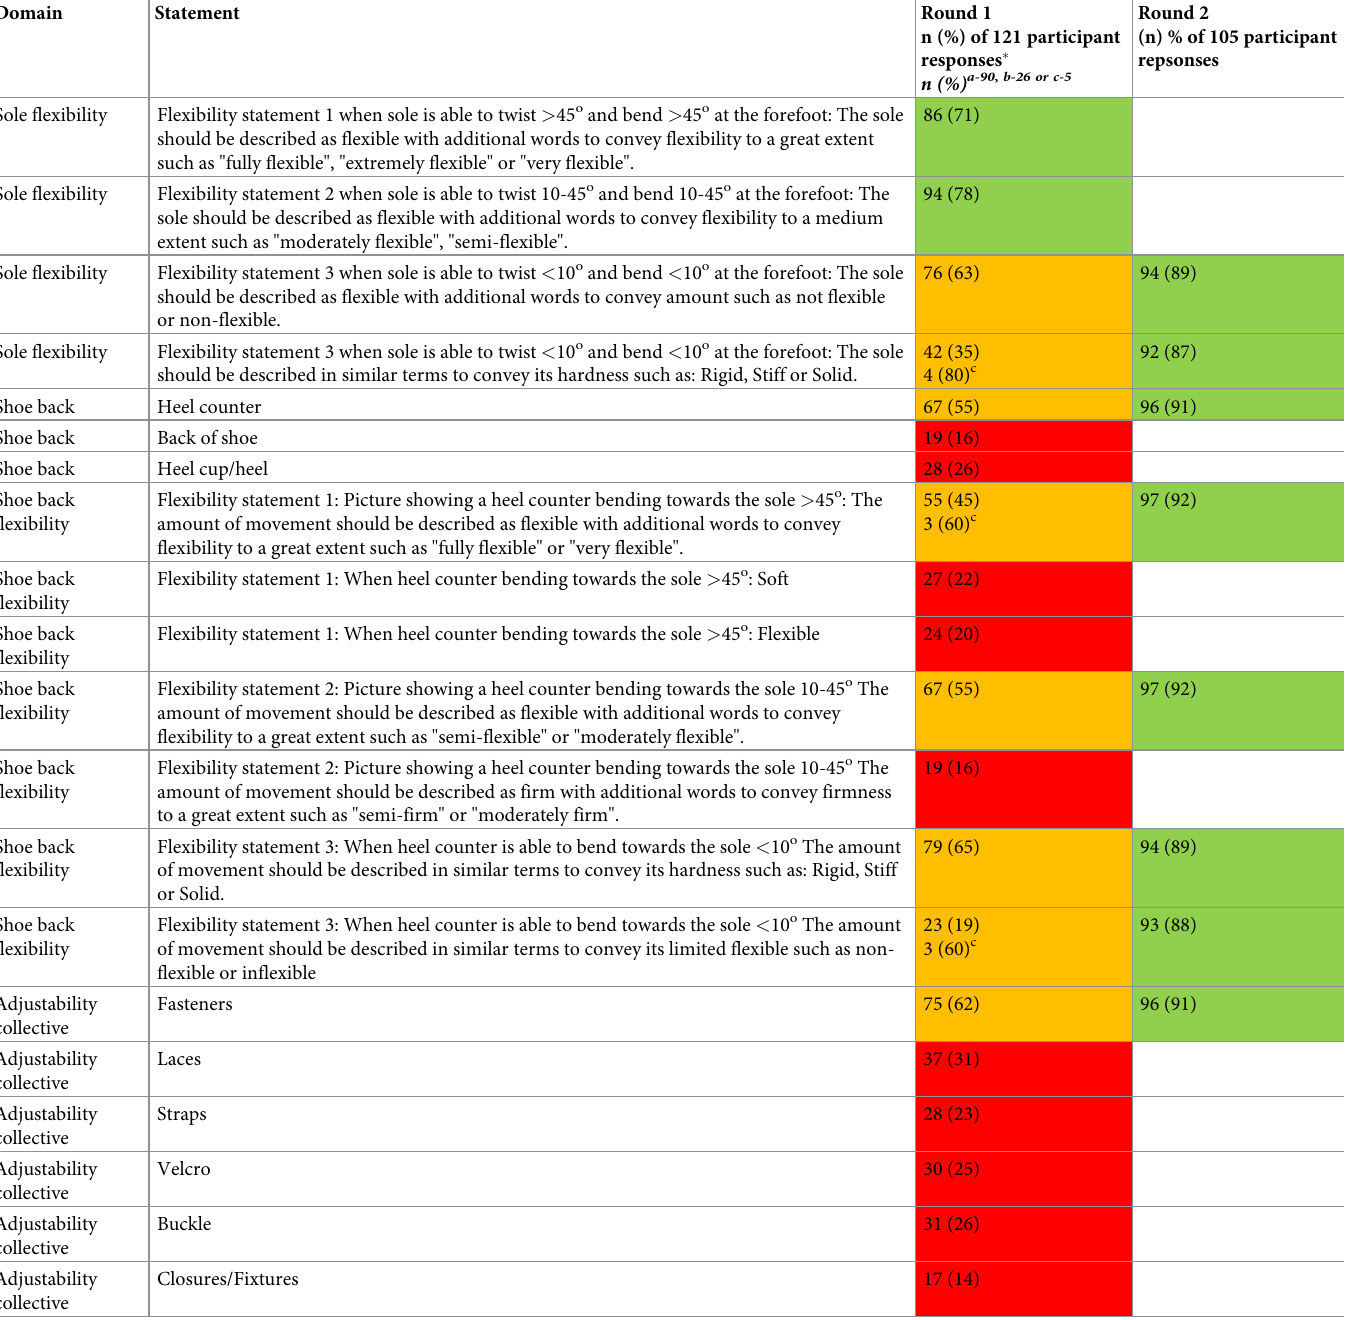
Table 4. Generated statements about how to describe the common features of footwear and round in which the statements were accepted.